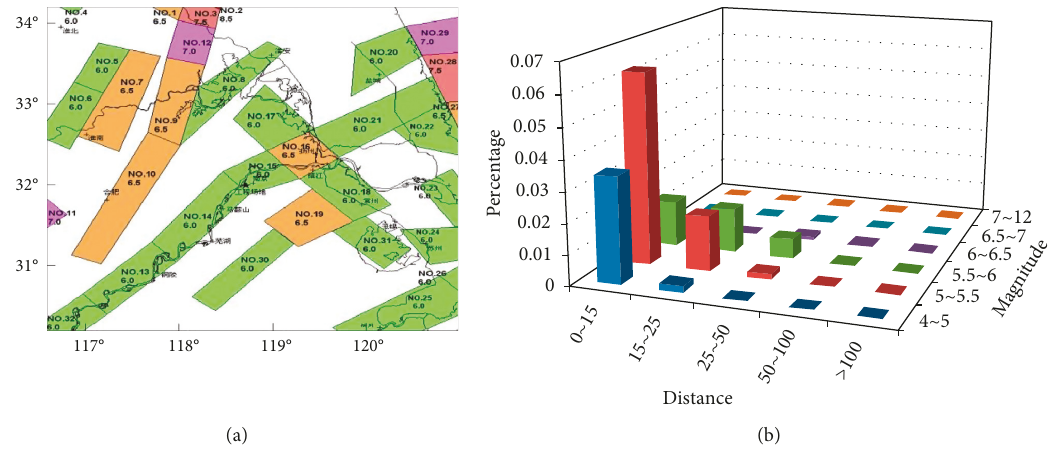
Figure 11: Probabilistic seismic hazard analysis of the site. (a) Potential seismic source. (b) Hazard deaggregation at the level of 10% in